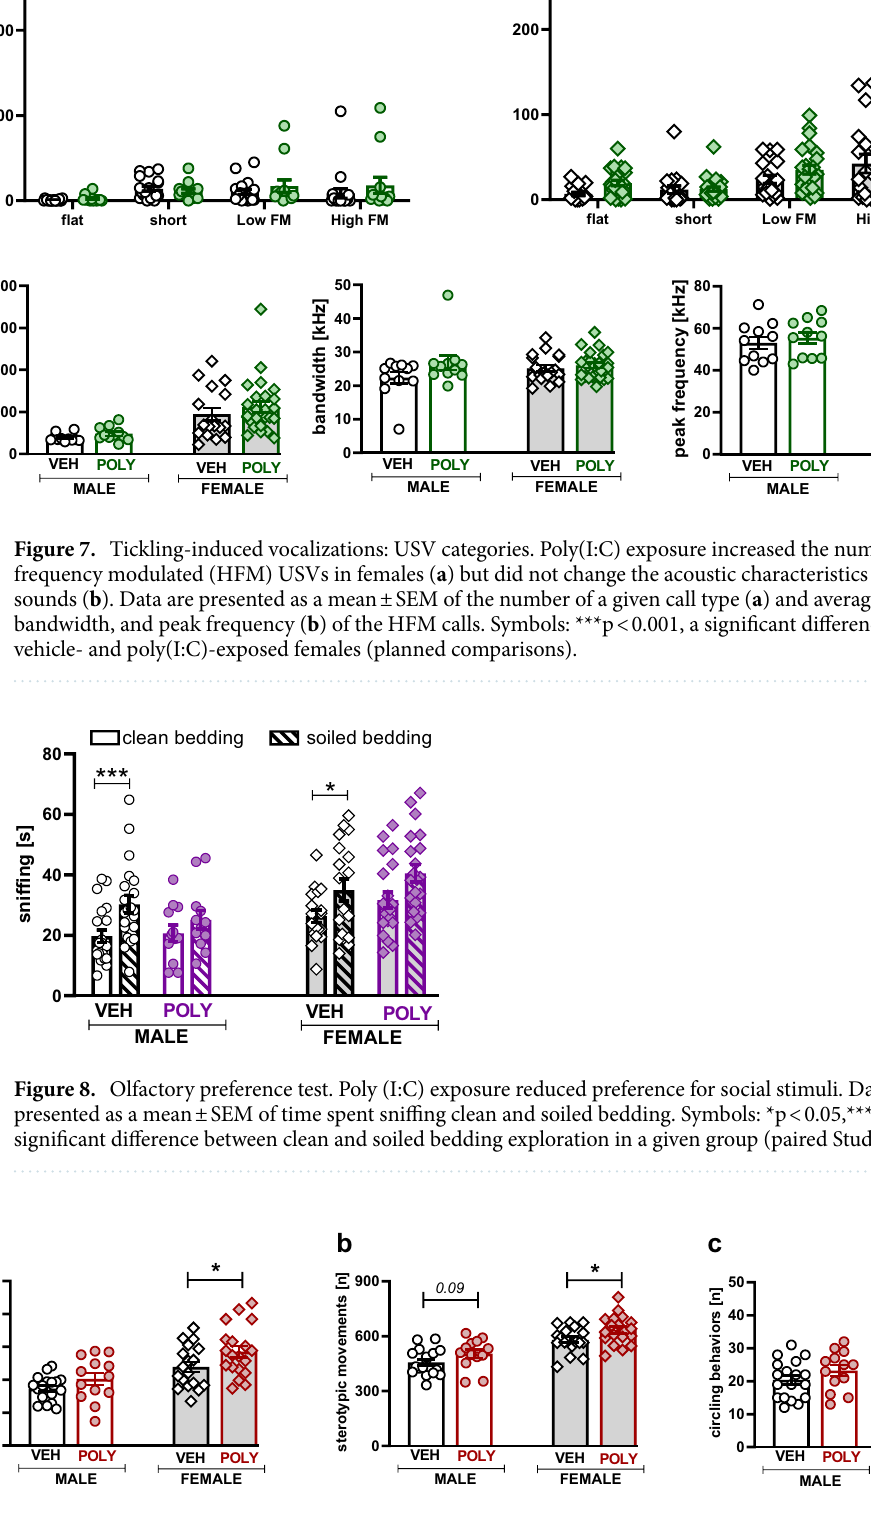
Figure 9. Locomotor activity. Poly(I:C) exposure increased the distance traveled ( a ), repetitive movements ( b ), and episodes of circling behavior ( c ). Data are presented as a mean ± SEM. Symbols: *p < 0.05, a significant difference between vehicle- and poly(I:C)-exposed females (planned